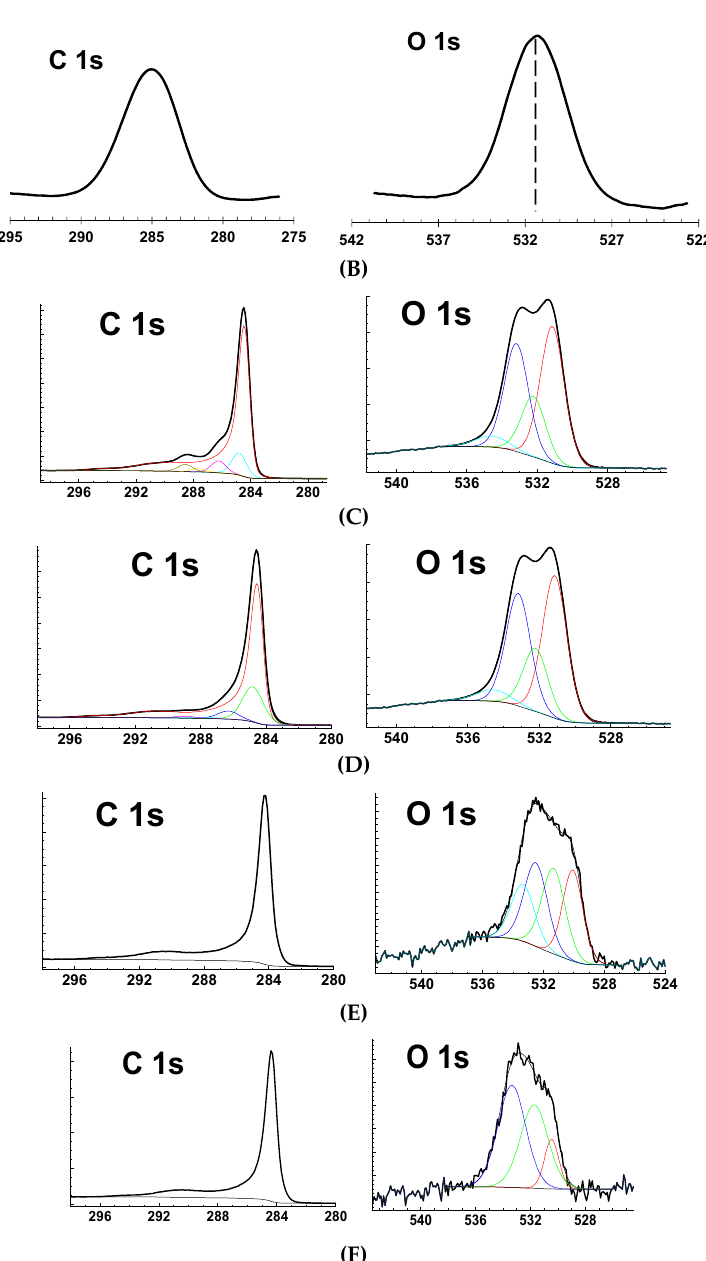
Figure A3. XPS images of CNMs used: ND ( A ), ND–COOH ( B ), rGiO ( C ), rGiO–H ( D ), MWCNT ( E ), MWCNT–H ( F ).